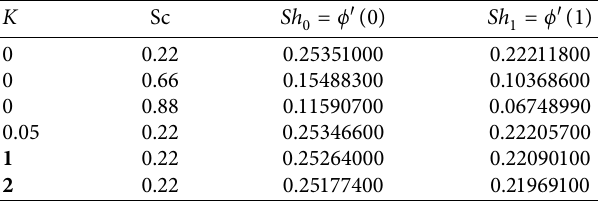
Table 3: Results of the Sherwood number for various values of physical